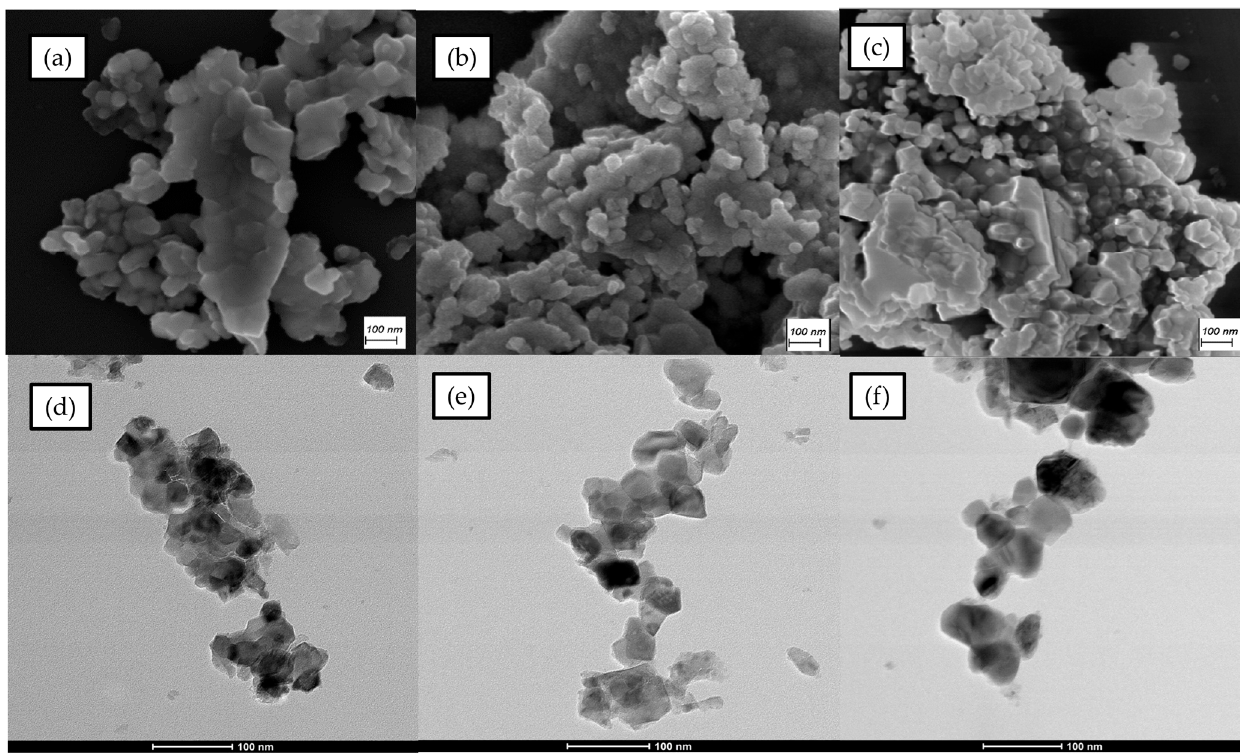
Figure 4. FESEM and TEM images of MgFe 2 O 4 ( a ) and ( d ); Ni 0.5 Mg 0.5 Fe 2 O 4 ( b ) and ( e ); and NiFe 2 O 4 ( c ) and ( f